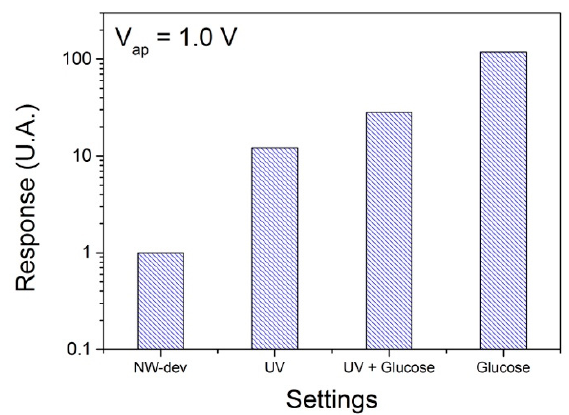
Figure 6. Response bar-graph of device based SnO 2 nanowire sensor in four different settings: only nanowire (NW-dev); under UV (UV); combined effect between UV light and 1 mole of GLU (UV + Glucose) and under 1 mole of GLU (Glucose).